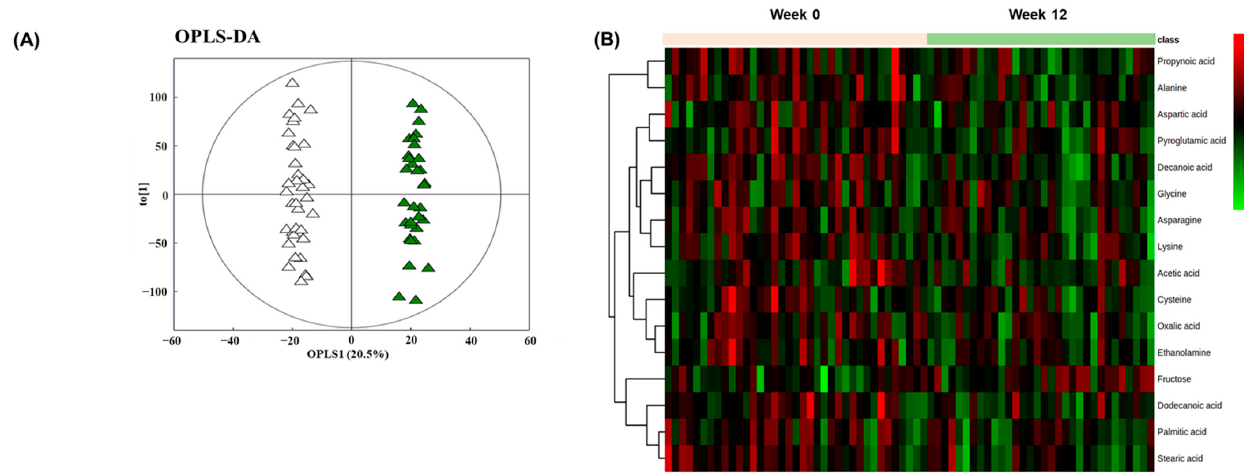
Figure 3. BSE supplementation alters the circulating metabolome. ( A ) OPLS-DA score plot for the GC-TOF-MS data of each sample ( △ week 0; ▲ week 12). ( B ) Heatmap overview of the differential metabolomes before and after BSE supplementation. BSE, barley sprouts extract powder; OPLS-DA, orthogonal partial least-squares discriminant analysis; GC-TOF-MS, gas chromatography coupled to time-of-flight mass spectrometry.